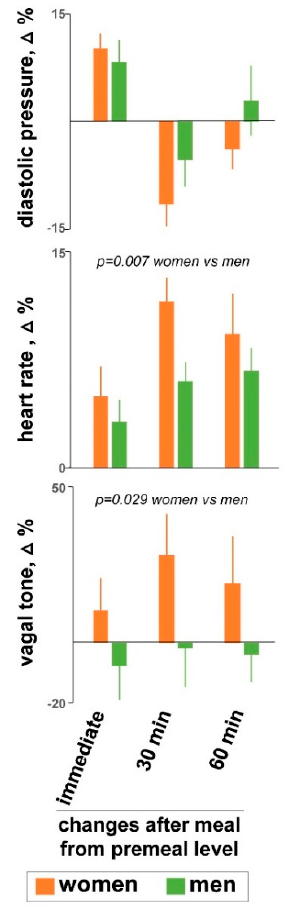
Figure 2. Physiological responses to probe meal. Data are postprandial changes from premeal baseline (mean ± SE). Overall, meal ingestion was associated with an increase in diastolic blood pressure, heart rate and vagal tone (main time-effect p ≤ 0.003 for all; n = 24). As compared to men, women exhibited more pronounced effects on heart rate and vagal tone (by ANCOVA).